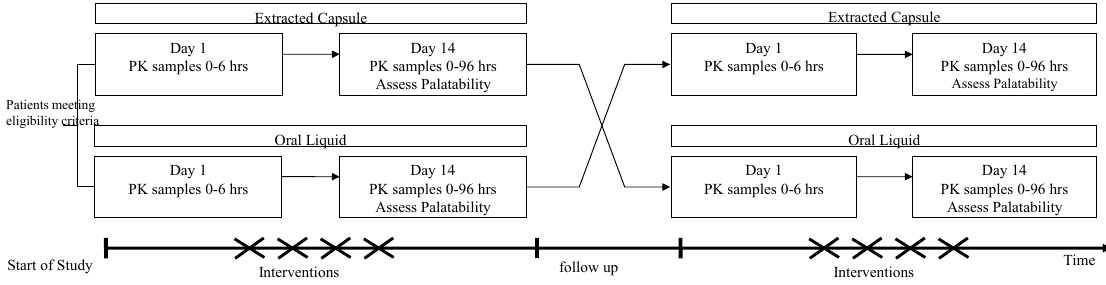
Figure 1. Schematic of study design.